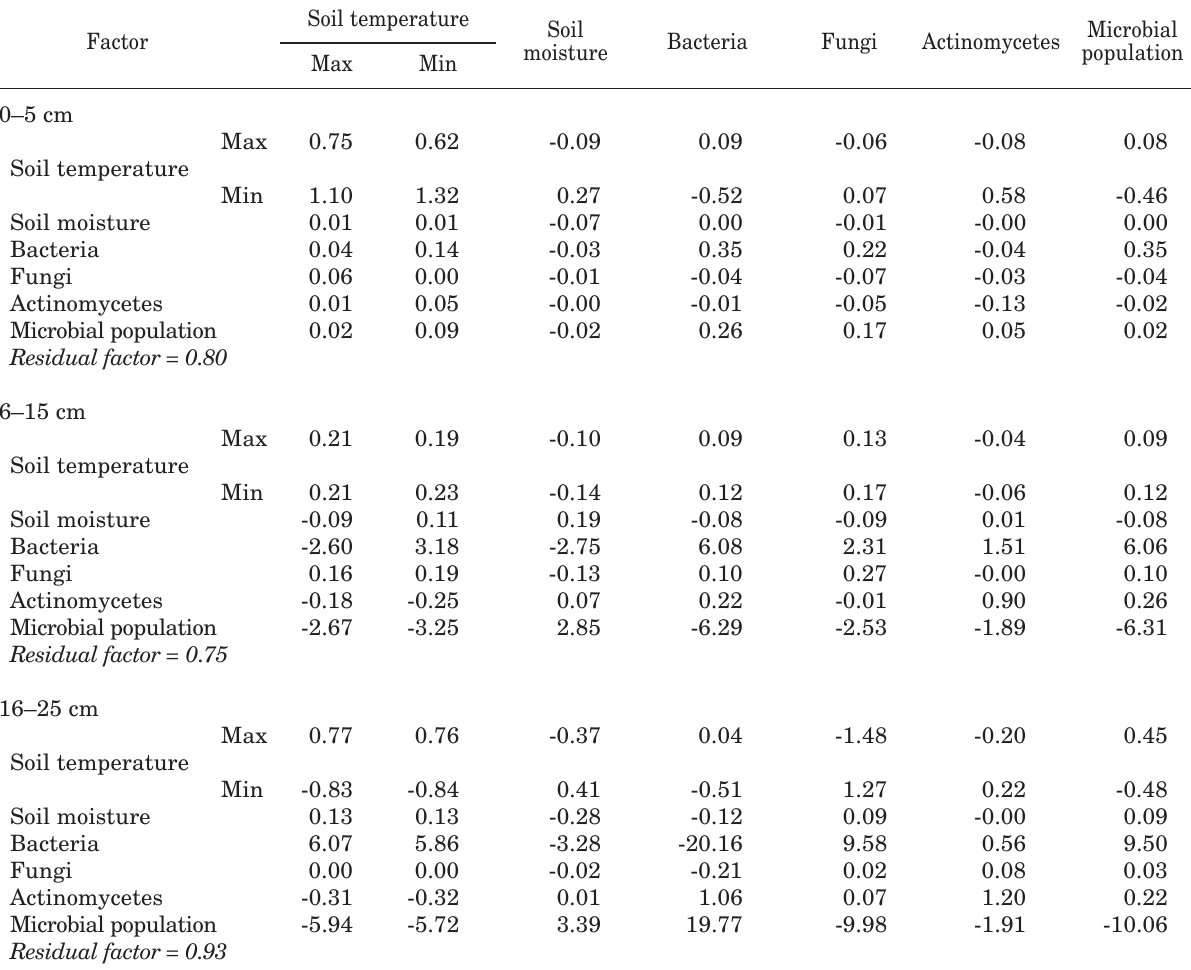
Table 2. Direct and indirect effects of certain factors influencing Fusarium oxysporum f. sp. cumini populations at different soil depths in fallow